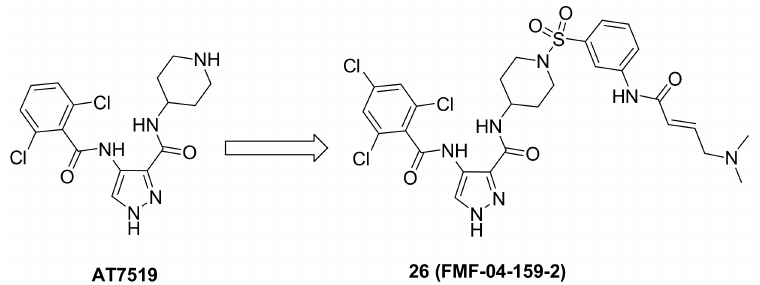
Figure 29. Structure of AT7519 and the development of compound 26